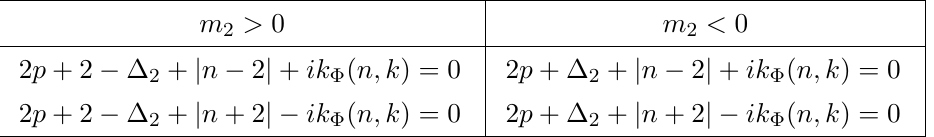
Table 5 . Conditions satis(cid:12)ed by Euclidean solutions with chiral boundary conditions. Each solution satis(cid:12)es one of the conditions listed. Here k (cid:8) ( n; k ) is given in equation (2.19). In this table, p runs over all non-negative integers, whereas n and k run over all